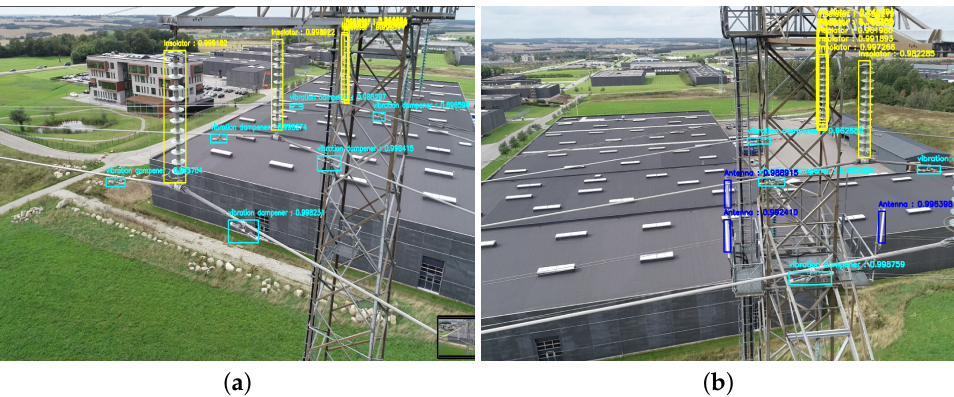
Figure 13. Detection results of different components of power line pylons based on